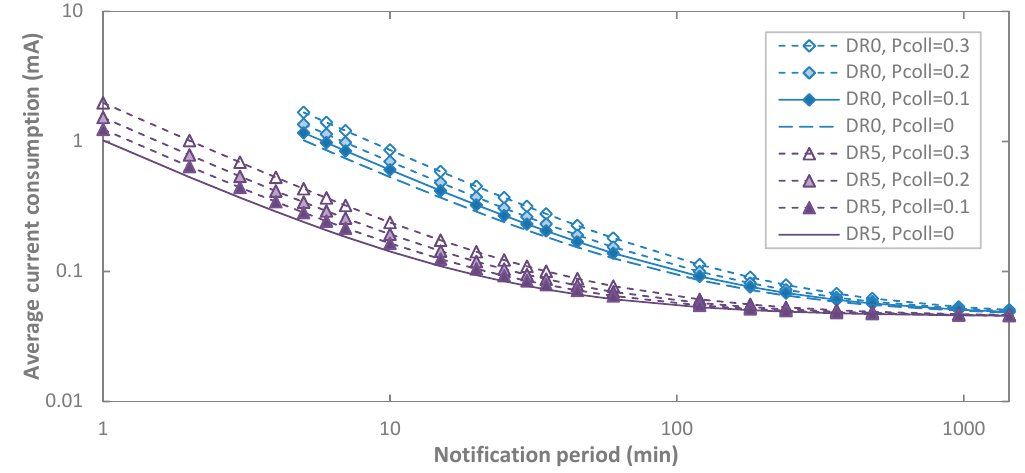
Figure 12. Impact of p coll on the average current consumption of the end-device in acknowledged transmission, as a function of T Notif , for different DR settings and for BER = 0.